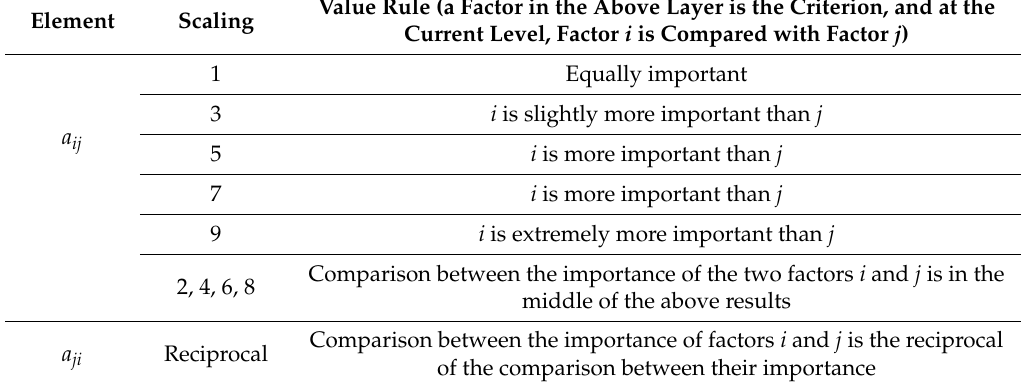
Table 1. Analytical method with two-two comparison scale